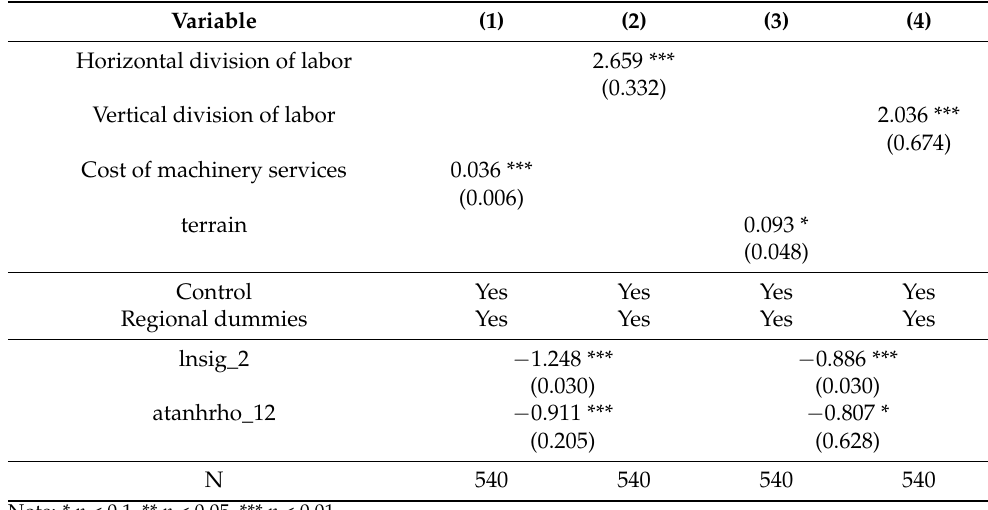
Table 6. Result of CMP